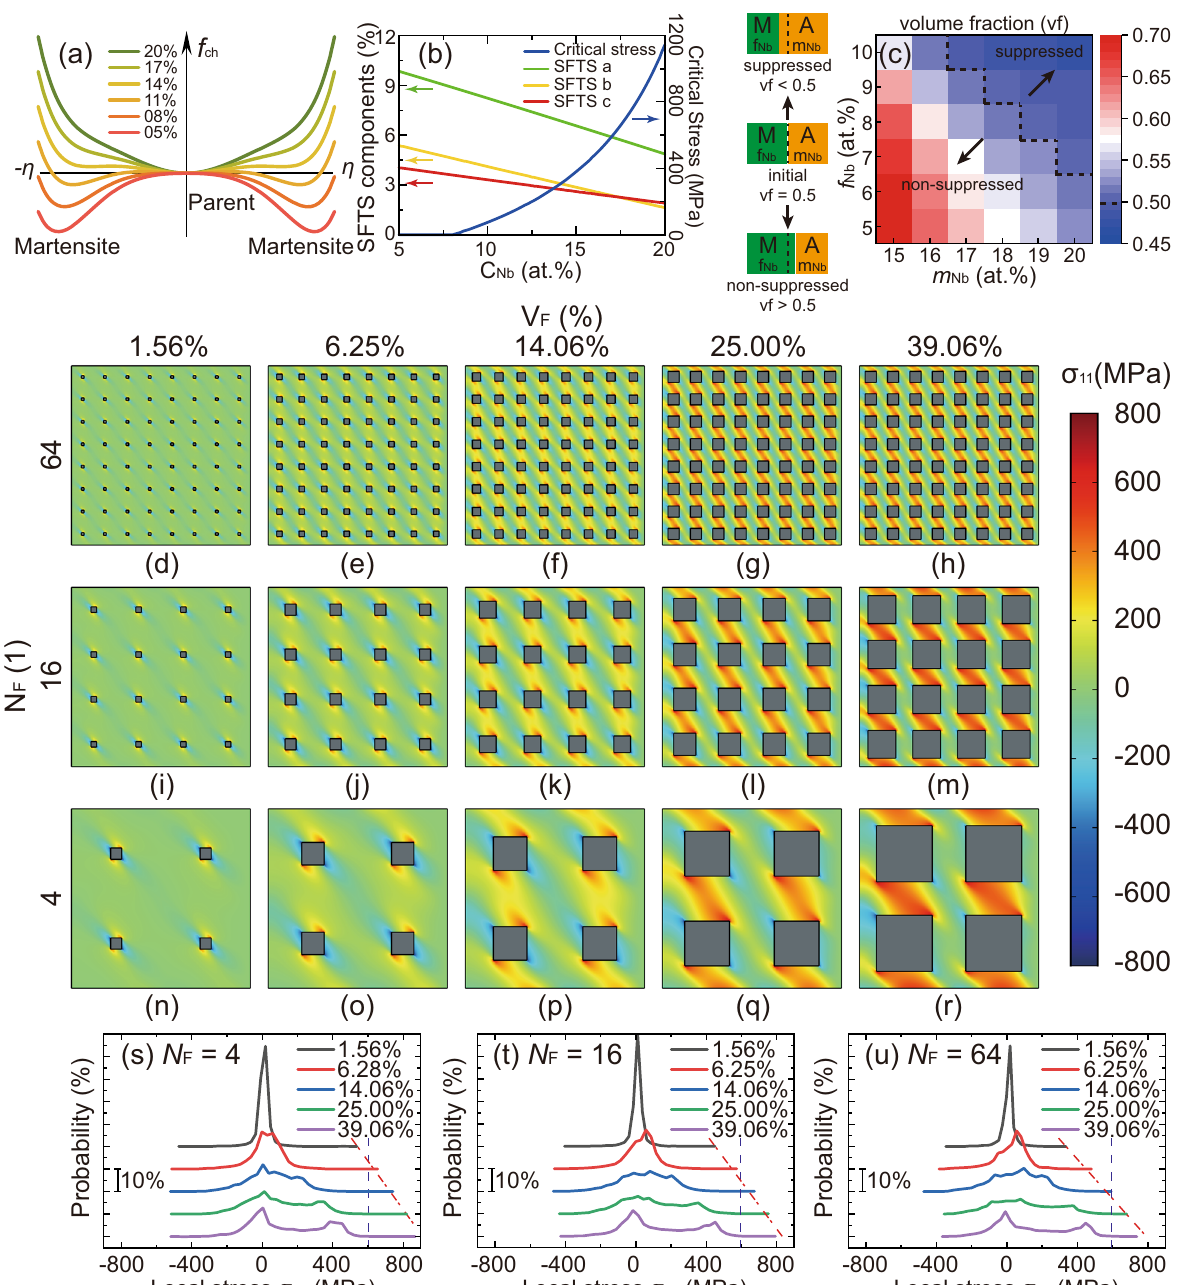
Fig. 3 Schematic diagrams for the understanding of physical origin to achieve the speci fi ed properties of the nanocomposites. a Landau free-energy curves with different C Nb , b SFTS tensors component, and MT critical stress with different C Nb , and c the ability that Nb-rich matrix inhibits the spread of martensite in fi llers into matrix determined by F Nb and M Nb . d – r Local stress fi eld on the [100] direction of Ti-Nb nanocomposites of different V F and different N F and s – u local stress fi eld probability distribution with V F = 1.56, 6.28, 14.06, 25.00, and 39.06% for different N F